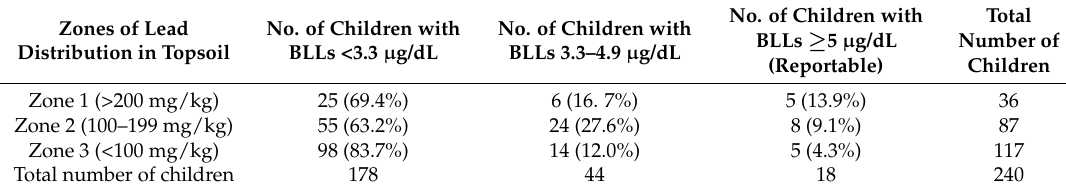
Table 1. Number of children in study Zones 1–3 (predicted high, moderate and low soil lead levels) found in the three categories of blood lead levels (undetectable, detectable, and reportable). Zones of Lead Distribution in